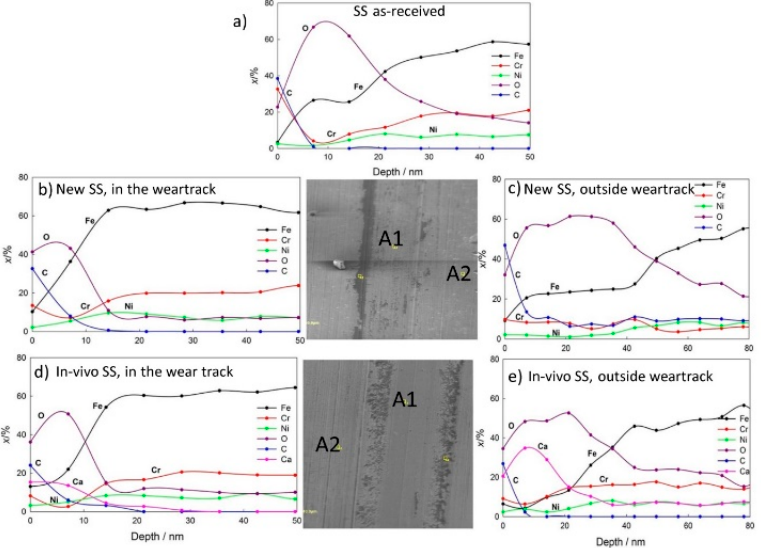
Figure 6. AES depth profiles for as-received SS archwire ( a ), SS new archwire in the wear track ( b ) and outside the wear track ( c ) and in vivo exposed SS archwire after tribocorrosion experiment, in the wear track ( d ) and outside the wear track ( e ); A1 analysis in the weartrack; A2 analysis outside the weartrack.